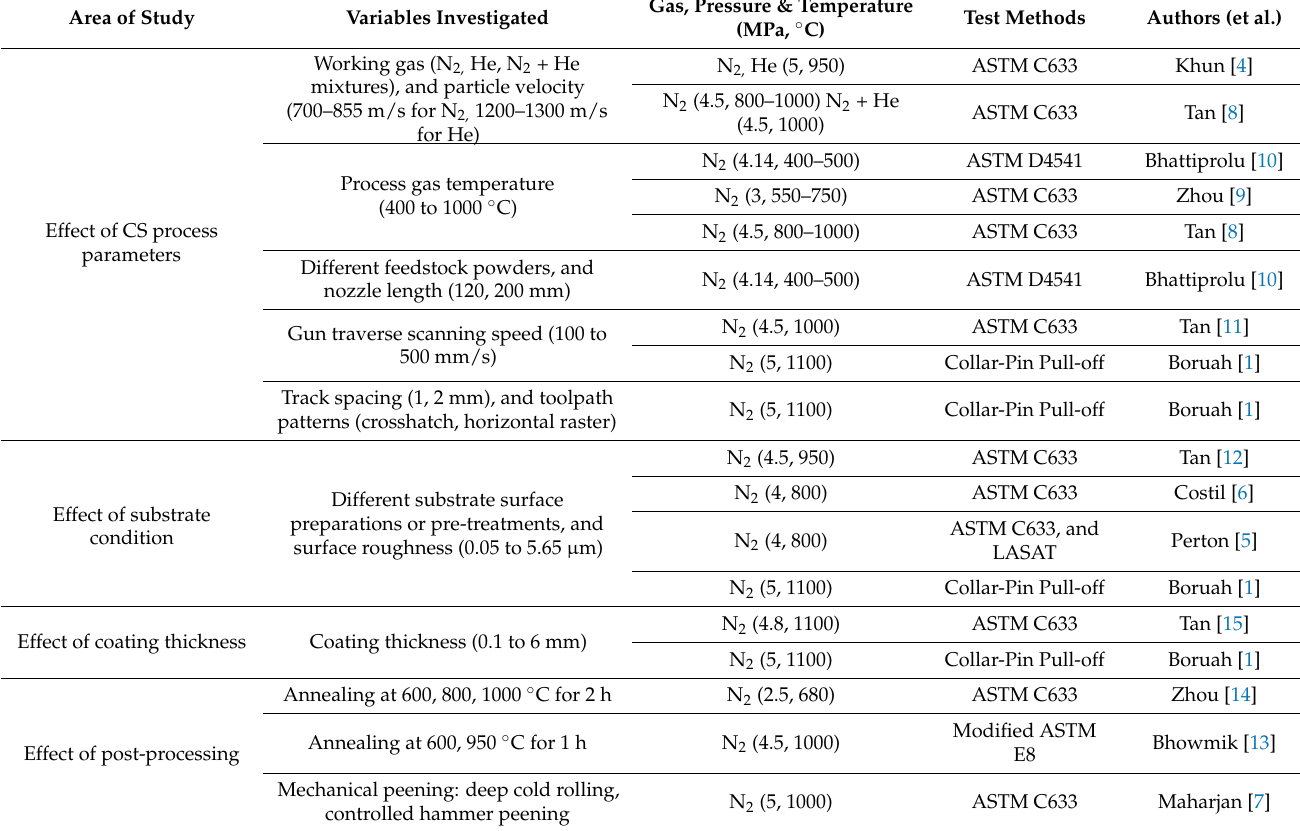
Table 1. Earlier studies reported the interfacial adhesion strength of CS Ti6Al4V deposited on Ti6Al4V